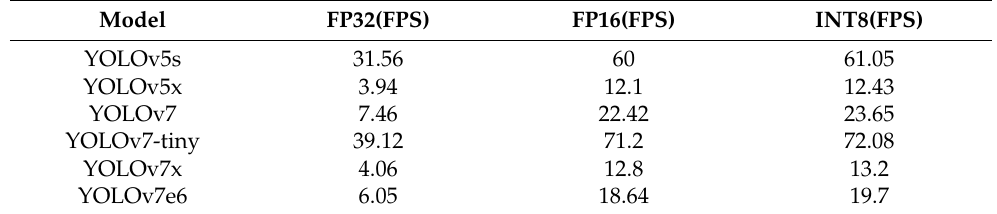
Table 2. Average frame rate of different models on DeepStream with FP32, FP16, and INT8 accuracy.